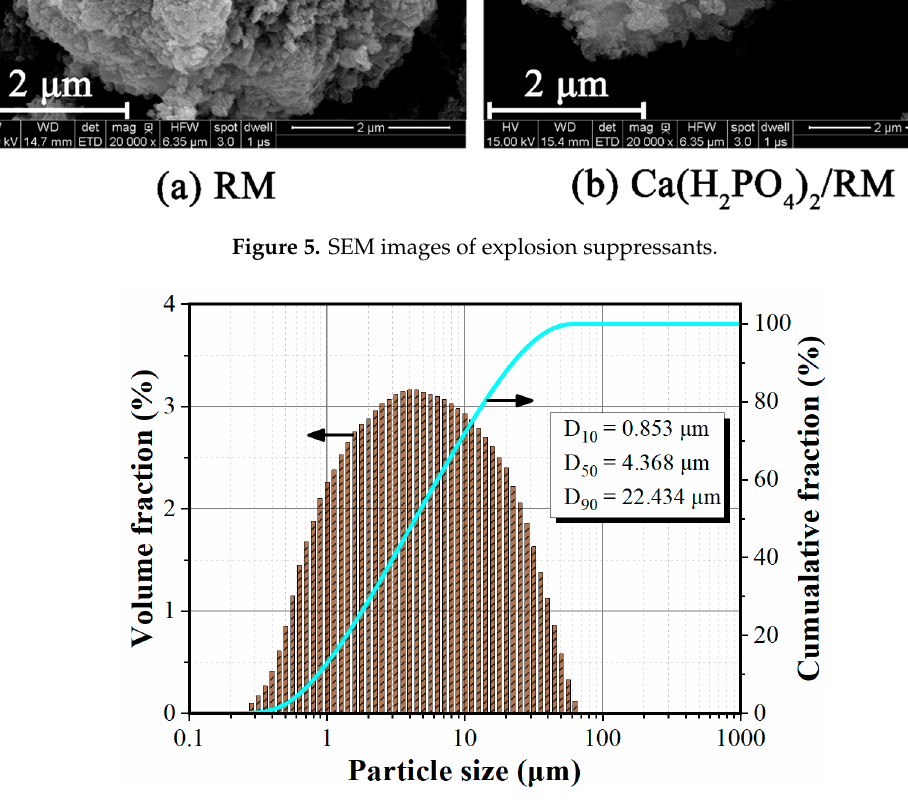
Figure 6. Particle size distribution of Ca(H 2 PO 4 ) 2 /RM composite suppressant.